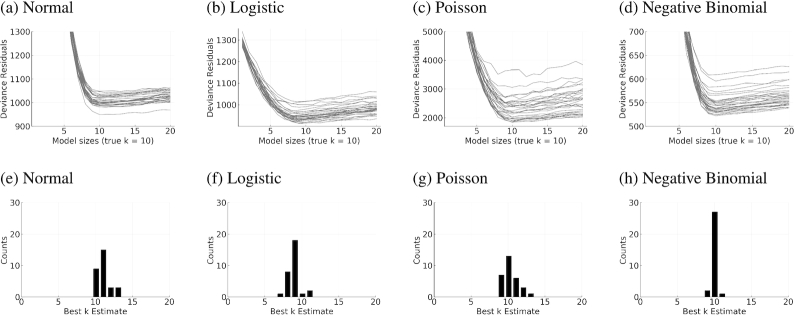
Five-fold cross-validation results are capable of identifying the true model size ktrue. (a–d) Deviance residuals of the testing set are minimized when the estimated model size \documentclass[12pt]{minimal}
\usepackage{amsmath}
\usepackage{wasysym}
\usepackage{amsfonts}
\usepackage{amssymb}
\usepackage{amsbsy}
\usepackage{upgreek}
\usepackage{mathrsfs}
\setlength{\oddsidemargin}{-69pt}
\begin{document}
}{}$\hat{k} \approx k_{\rm true}$\end{document}. Each line represents 1 simulation. (e–h) \documentclass[12pt]{minimal}
\usepackage{amsmath}
\usepackage{wasysym}
\usepackage{amsfonts}
\usepackage{amssymb}
\usepackage{amsbsy}
\usepackage{upgreek}
\usepackage{mathrsfs}
\setlength{\oddsidemargin}{-69pt}
\begin{document}
}{}$\hat{k}$\end{document} is narrowly spread around ktrue = 10.